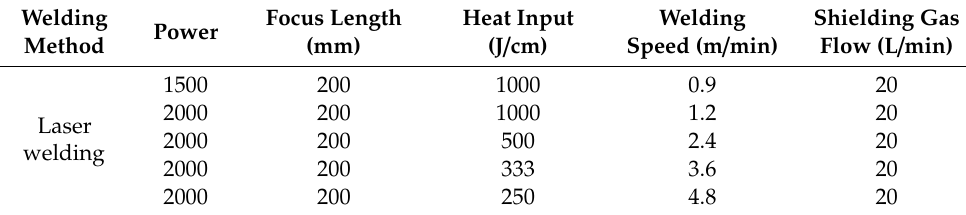
Table 2. Welding parameters of laser welding.